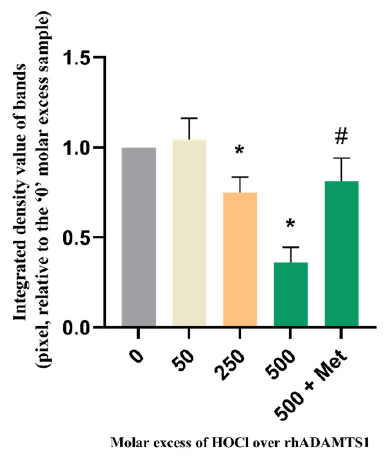
Figure 11. Effect of HOCl on rhADAMTS1 cleavage activity. rhADAMTS1 (99.8 nM) was exposed to 0, 50 ‐ , 250 ‐ and 500 ‐ fold molar excesses of reagent HOCl (0, 5 μ M, 25 μ M, and 50 μ M, respectively) for 15 min at 37 °C, before addition of rhAggrecan (molar ratio of rhAggrecan:rhADAMTS1, 6.5:1) and incubation for a total of 24 h at 37 °C. Samples were separated by SDS ‐ PAGE, transferred to membranes and subjected to Western blotting by using the BC ‐ 3 mAb (1:1667 dilution) as indicated in the legend to Figure 3. The pixel density of the band (determined by using ImageJ software) de ‐ tected for the untreated enzyme was compared to the HOCl ‐ treated samples. In some experiments with a 500 ‐ fold molar excess of HOCl, 1 mM Met was added before addition of the HOCl. Data are presented as mean ± SD from three independent experiments. Statistical analysis was performed relative to the 0 ‐ fold molar excess of oxidant by using one ‐ way ANOVA with Dunnett’s multiple comparisons test (for the different HOCl concentrations) and unpaired t test with Welch’s correction (for the effect of Met). Statistical significance ( p < 0.05) compared to the untreated enzyme is indi ‐ cated by *; significance of the Met treatment, compared to the 500 ‐ fold molar excess of HOCl, is indicated by #. 3.8. Effect of HOCl on rhADAMTS1 Cleavage of rhAggrecan As both rhADAMTS1 and HOCl can cleave rhAggrecan, and HOCl can inactivate rhADAMTS1 (see above), it was of interest to determine whether HOCl also inhibited ADAMTS1 in the presence of rhAggrecan, and what fragments might be formed when all three components were present simultaneously, as is likely to occur in vivo. rhADAMTS1, rhAggrecan and HOCl (molar ratios: 1:6.5:500–5000) were incubated for 24 h at 37 °C with fragment and aggregate formation examined by SDS ‐ PAGE and Western blotting by us ‐ ing the BC ‐ 3 mAb to detect the neoepitope generated by rhADAMTS1 cleavage. In the absence of HOCl, the two expected fragments from enzymatic cleavage were detected (Figure 12A, lane 1 versus lane 2). In the additional presence of increasing concentrations of HOCl, these bands were lost, and the fragments and dimer/aggregates generated by HOCl were detected instead (Figure 12A, lanes 3–7). The corresponding Western blot for the rhADAMTS1 neoepitope confirmed a decreased yield of this fragment with increasing HOCl exposure (Figure 12C,D), with this ascribed to HOCl ‐ mediated rhADAMTS1 inac ‐ tivation.